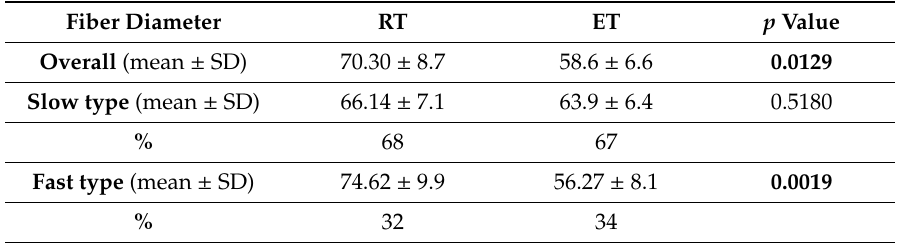
Table 4. Mean myofiber diameter calculated on skeletal muscle biopsies from RT and ET trained